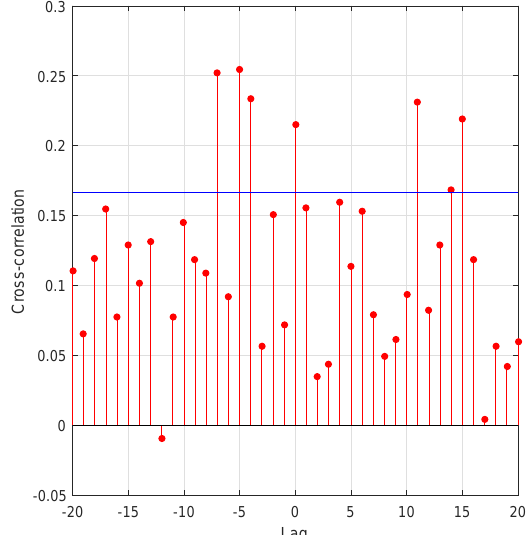
Figure 3. Cross-correlation between the monthly number of burglaries and CMIS in beat 11. From Figure 3, the counts of burglaries are weakly dependent with those of